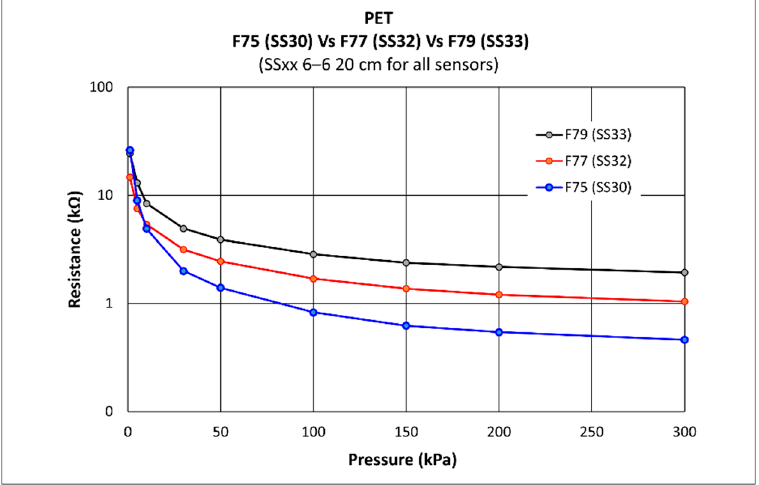
Figure 6. A comparison on ‘PET’ of QTSS™ F75 ink vs. QTSS™ F77 ink vs. QTSS™ F79 ink sensitivities.